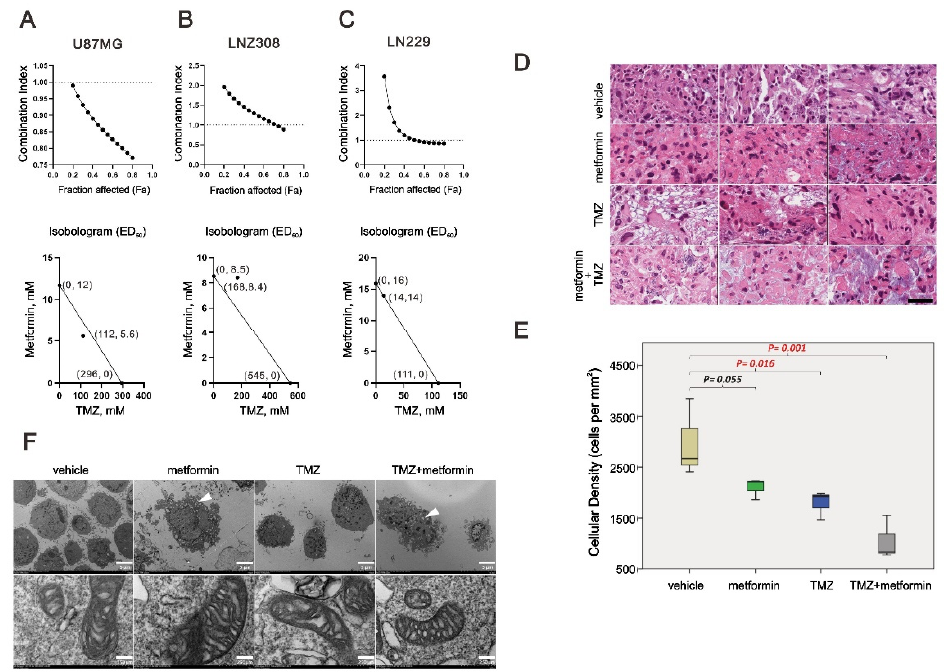
Figure 7. The combination index of TMZ and metformin in GBM cells. U87MG, LNZ308, and LN229 cells were treated with 0, 15.625, 31.25, 62.5, 125, 250, 500, 1000, 2000 m, and 4000 µM TMZ and 0, 3.125, 6.25, 12.5, 25, 50, 100, and 200 mM metformin for 72 h. Metabolic activity was measured using MTS assays. The combination index of TMZ plus metformin in U87MG ( A ), LNZ308 ( B ), and LN229 ( C ) cells. Isobolograms (ED 50 ) of TMZ or metformin were calculated using CalcuSyn software. ( D , E ) Patient-derived organoid culture was separated into four groups with different drug supplements, including Vehicle, 50 mM metformin, 100 µM TMZ, and combined 50 mM metformin with 100 µM TMZ. Scale bar = 50 µm. ( F ) LN229 cells were treated with 50 mM metformin, 12.5 µM TMZ, or their combination. After 48 h, the detailed mitochondrial structure of LN229 cells was investigated using the H-7500 TEM. Scale bar = 5 µm (top) and 250 µm (bottom).